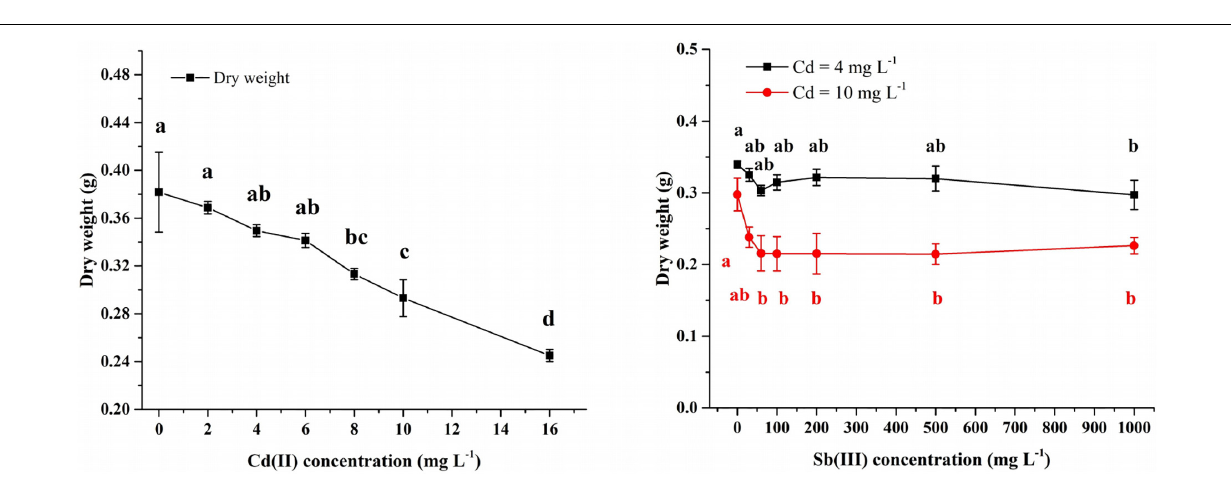
FIGURE 3 | Concentration of Cd(II) and Sb(III) affecting the growth of XK8. Letters indicate results of one-way ANOVA. If the letters are completely different, the difference is significant ( p < 0.05), otherwise the difference is not significant ( p >